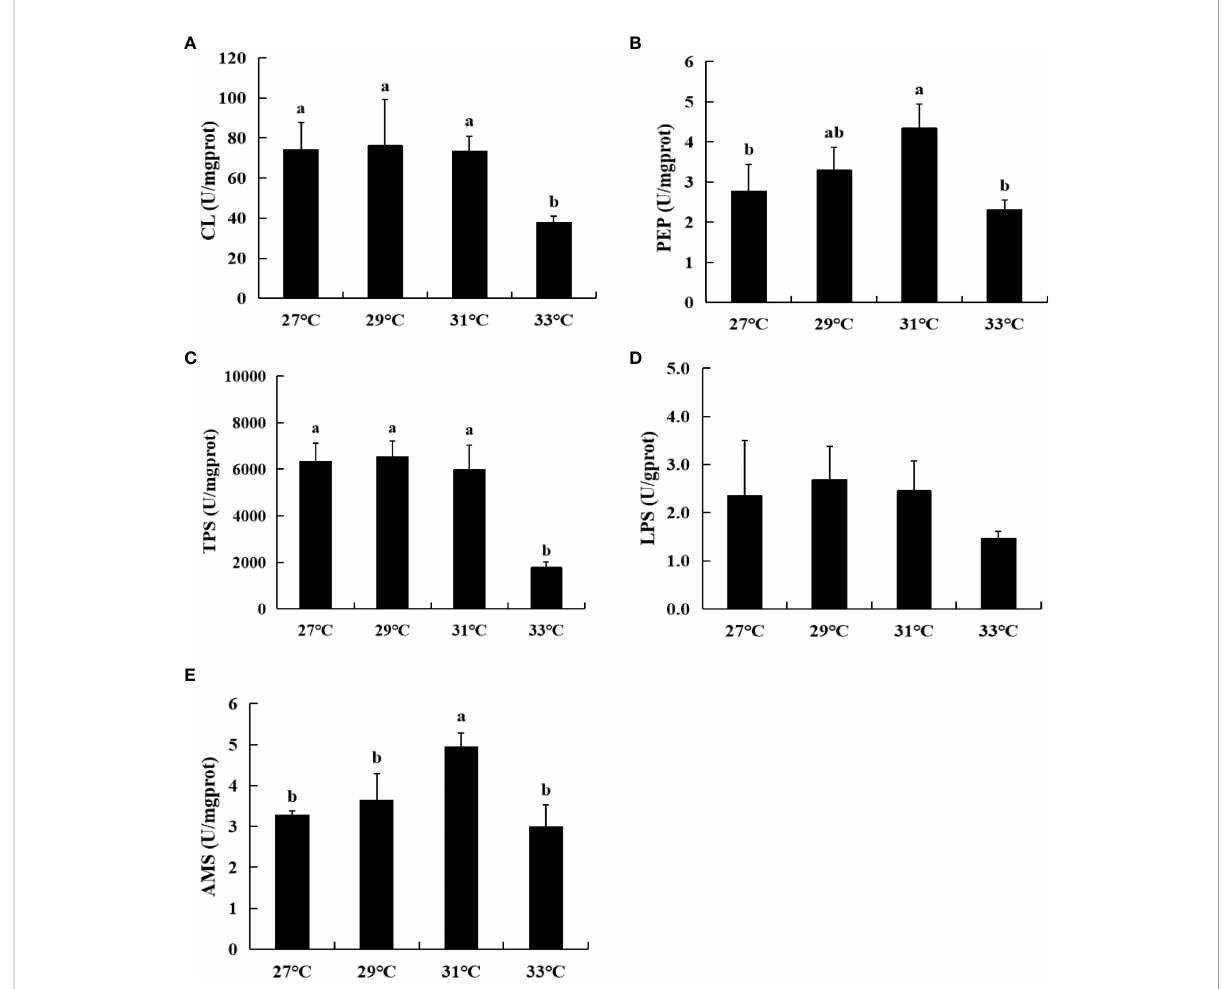
FIGURE 7 Digestive enzyme activity of newly hatched larvae of swimming crab at four water temperatures during embryonic development. (A) Cellulase (CL); (B) Pepsin (PEP); (C) Trypsin (TPS); (D) Lipase (LPS); (E) a -amylase (AMS). Different lowercase letters above the fi gure column indicate that there are signi fi cant differences between different temperature groups ( P<